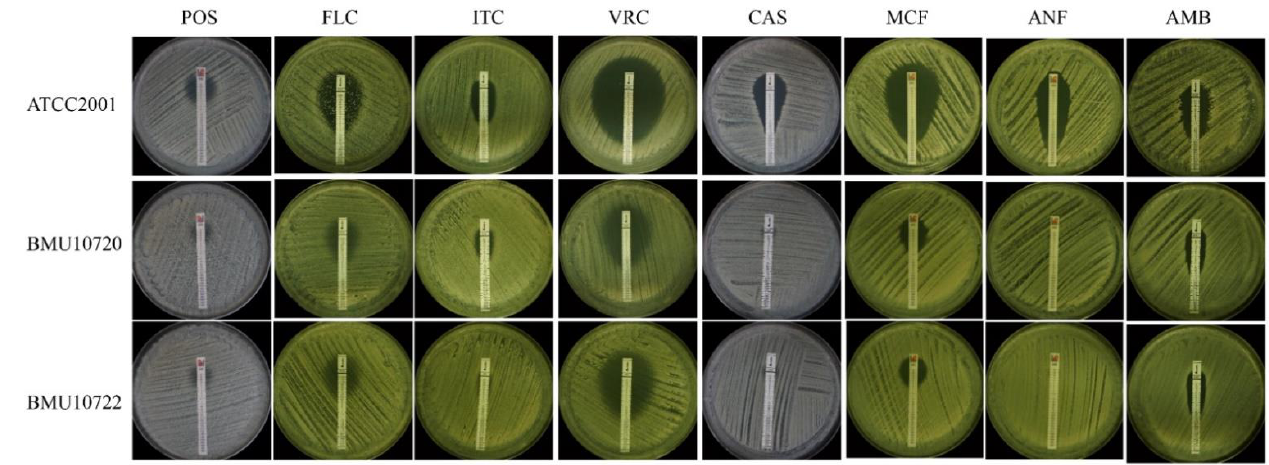
Figure 1. Antifungal susceptibility of ATCC2001, BMU10720, and BMU10722 performed by E-test. POS, posaconazole; FLC, fluconazole; ITC, itraconazole; VRC, voriconazole; CAS, caspofungin; MCF, micafungin; ANF, anidulafungin; AMB, amphotericin B. The inhibition zones of POS, FLC, ITC, VRC, CAS, MCF, ANF in BMU10720 and BMU10722 were smaller than those of ATCC2001, which were in accordance with the result of CLSI-M27 microdilution method. The inhibition zones of AMB in BMU10720 and BMU10722 were also smaller than that of ATCC2001, but they exhibited the same AMB MICs tested by CLSI-M27 microdilution method.